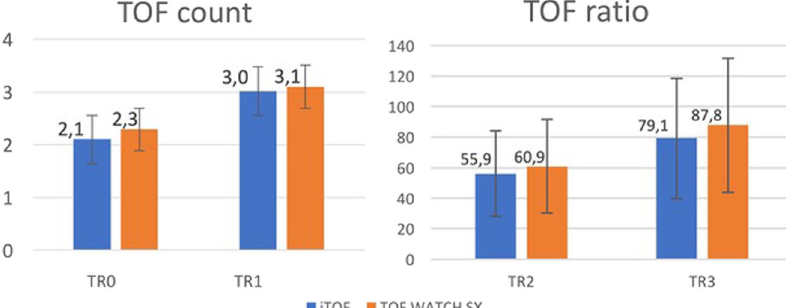
Fig. 3 Neuromuscular scores during the recovery period. Diagram comparing means of the TOF count (left side, expressed in absolute value) and TOF ratio (right side, expressed in percentage) between i-TOF and TOF WATCH SX among the different recovery times.